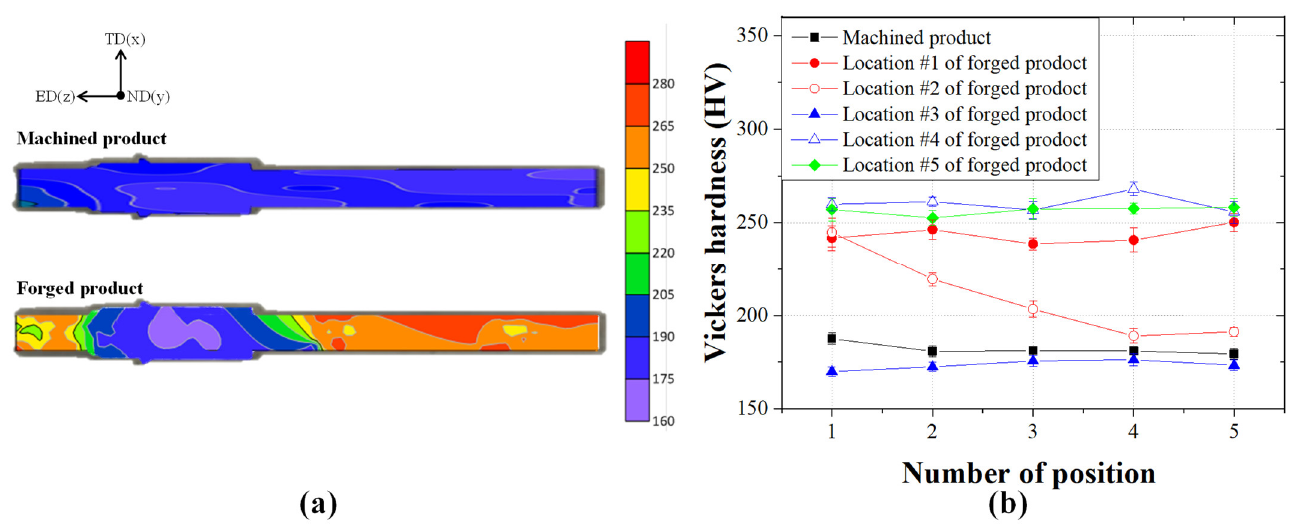
Figure 9. ( a ) Contour plots and ( b ) comparison graph of the Vickers hardness test results for the machined and forged products.